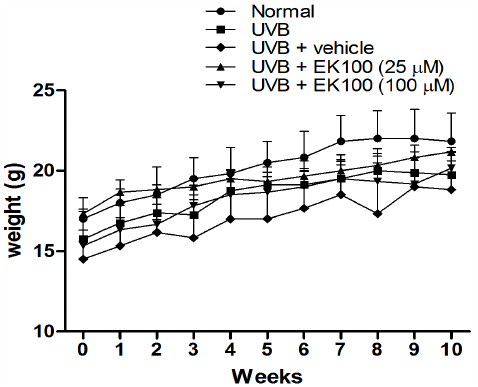
Figure 1. Body weight of the mice in the five groups.